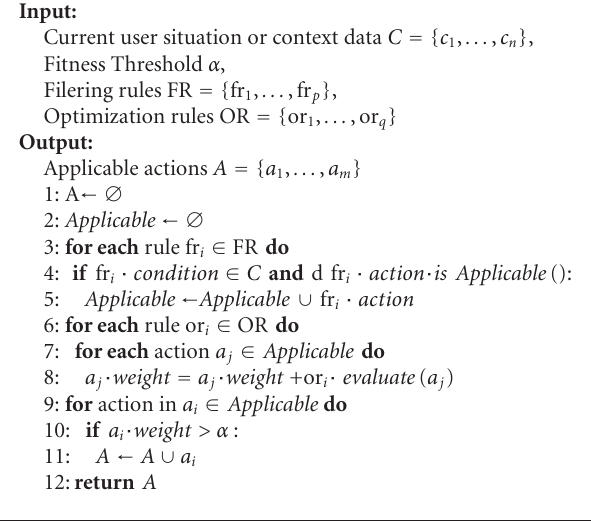
Algorithm 1: Reasoning on contextual information.